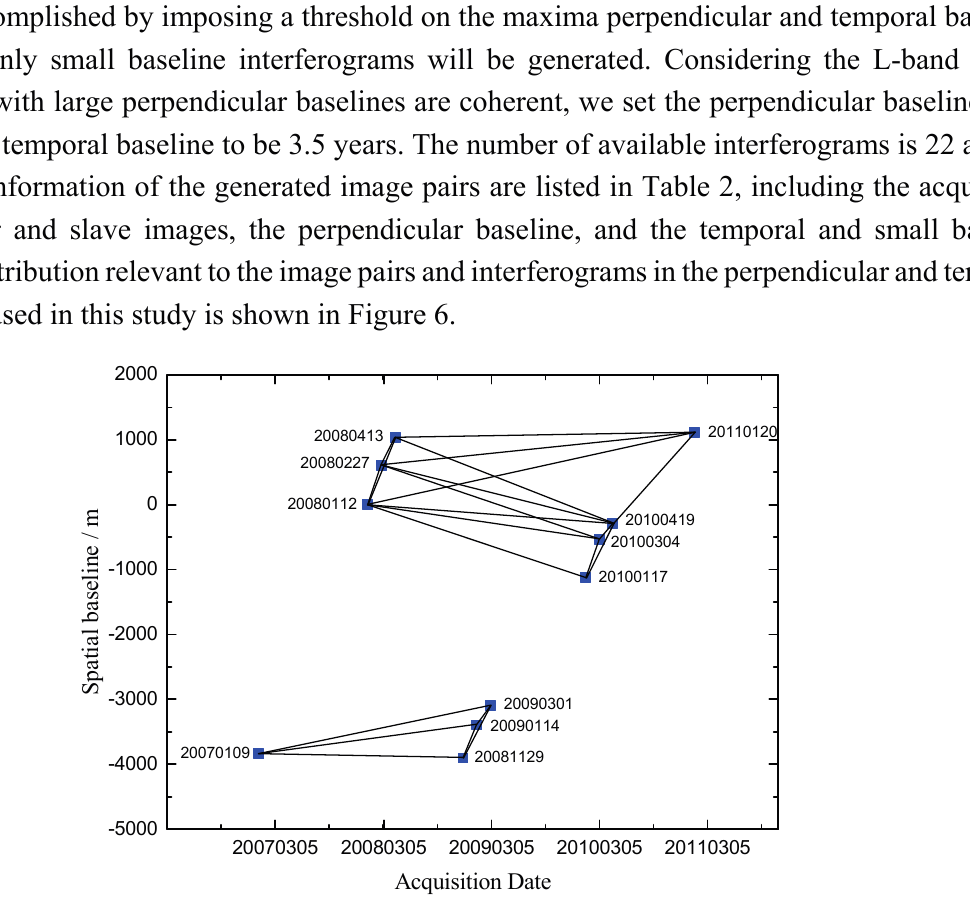
Figure 6. The distribution of ALOS PALSAR image pairs in the spatial and temporal baseline plane of two small baseline